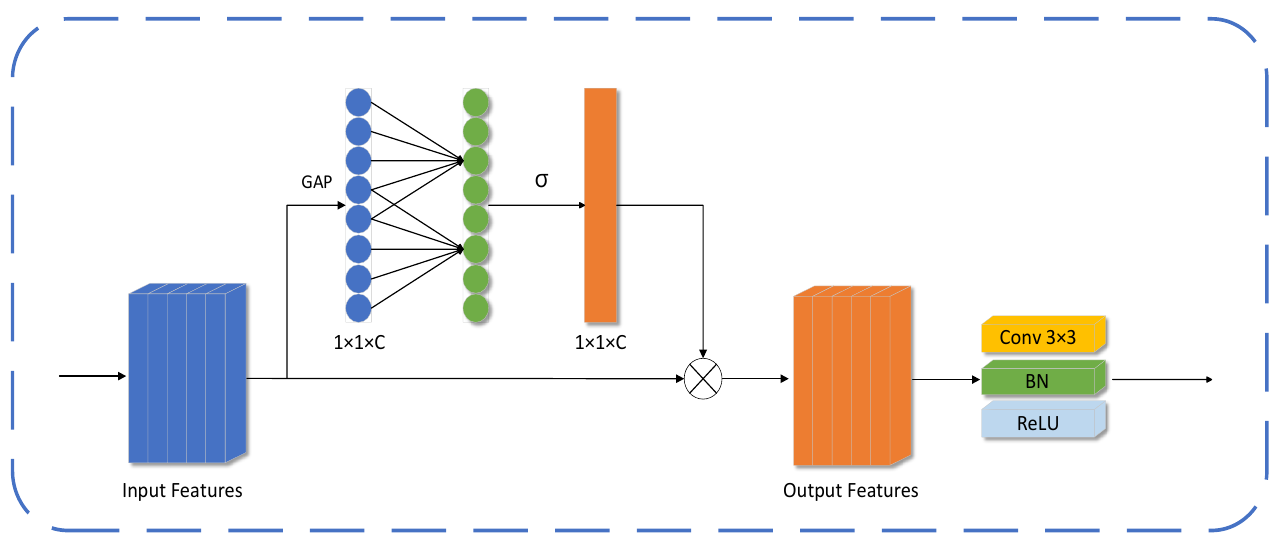
Figure 2. ECA-C module structure diagram.